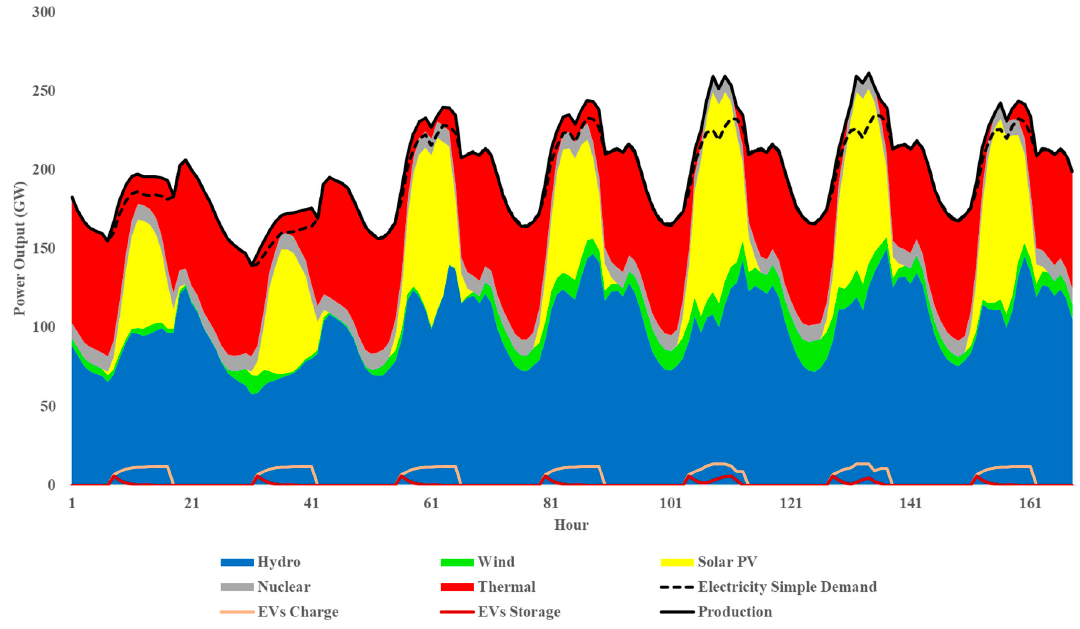
Figure 5. Power output on a fall week for scenario RES – Daily charging strategy.